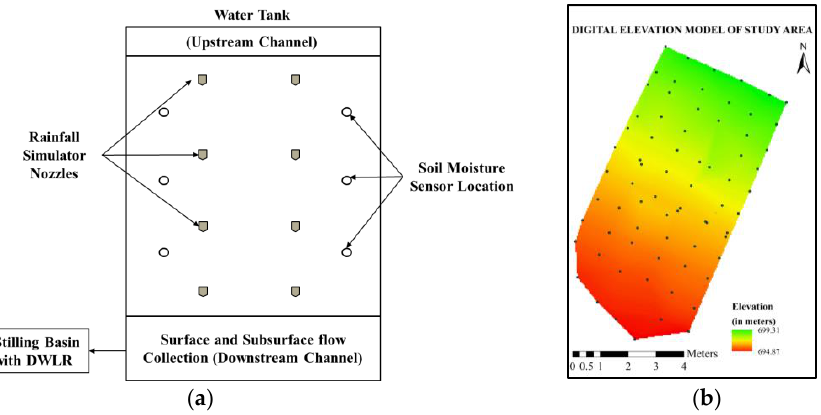
Figure 2. ( a ) Schematic diagram of the experimental setup; ( b ) Digital elevation model (DEM) of the experimental hillslope plot. DWLR: Digital water level recorder.